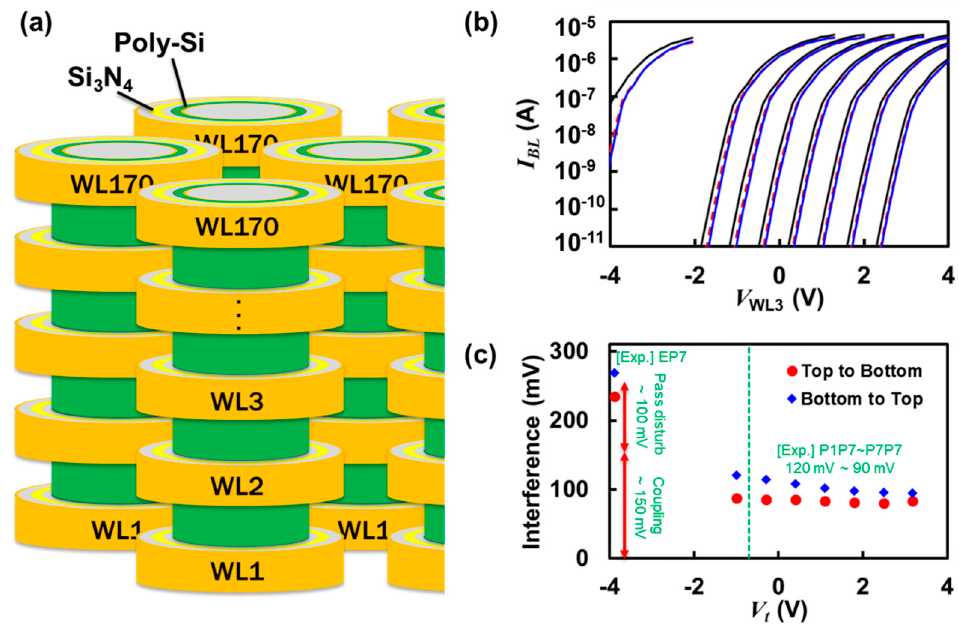
Figure 1. ( a ) Vertical NAND (VNAND) Flash cell array schematic showing neighbors both intra-string (Z-interference) and inter-string. Z-interference is the most critical since the channel is shared in close proximity for VNAND products. ( b ) Current versus voltage data as a function of the gate voltage of the victim cell (WL3). Solid line represents the reference state before the aggressor cell is programmed. Red dashed line and blue solid line denote the states after interference by T-B and B-T, respectively. ( c ) Interference of 8 different states (E, P1, P2, P3, P4, P5, P6, and P7) for triple level cell (TLC) under the condition of the aggressor programmed to P7 ( V t = 3.177 V). Blue diamonds and red circles show the results out of Bottom to Top (B-T, WL4 is aggressor) and Top to Bottom (T-B, WL2 is aggressor), respectively. Remarks with (Exp.) denote experimentally measured interferences (unpublished) from Samsung’s 4th generation VNAND (Ref. [18]).